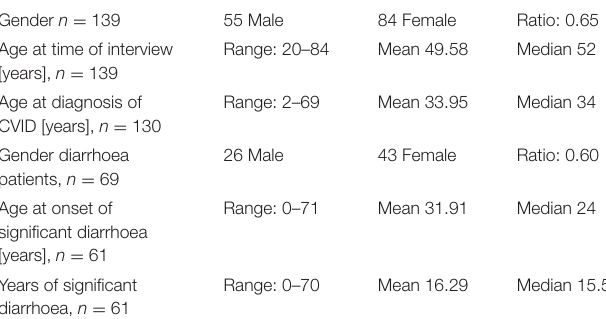
TABLE 1 | Descriptive details of interviewed cohort of CVID patients.